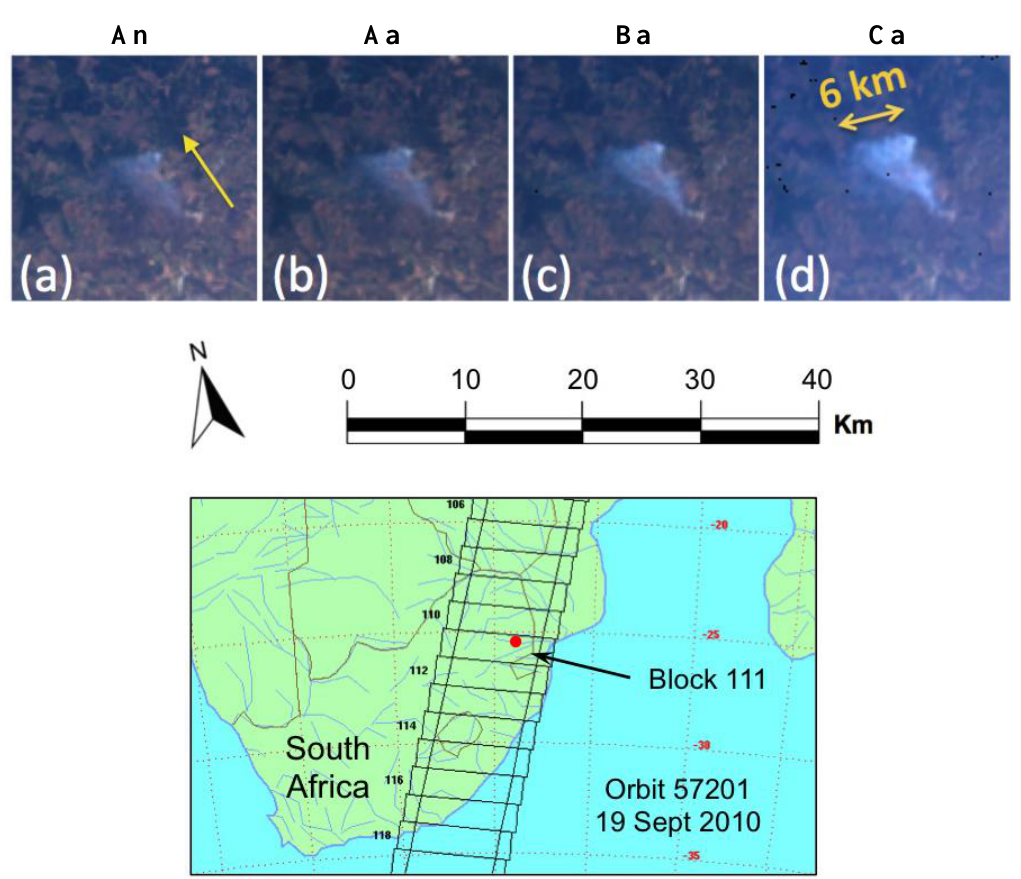
Figure 7. Local mode (275 m resolution in all channels) RGB images of a smoke plume